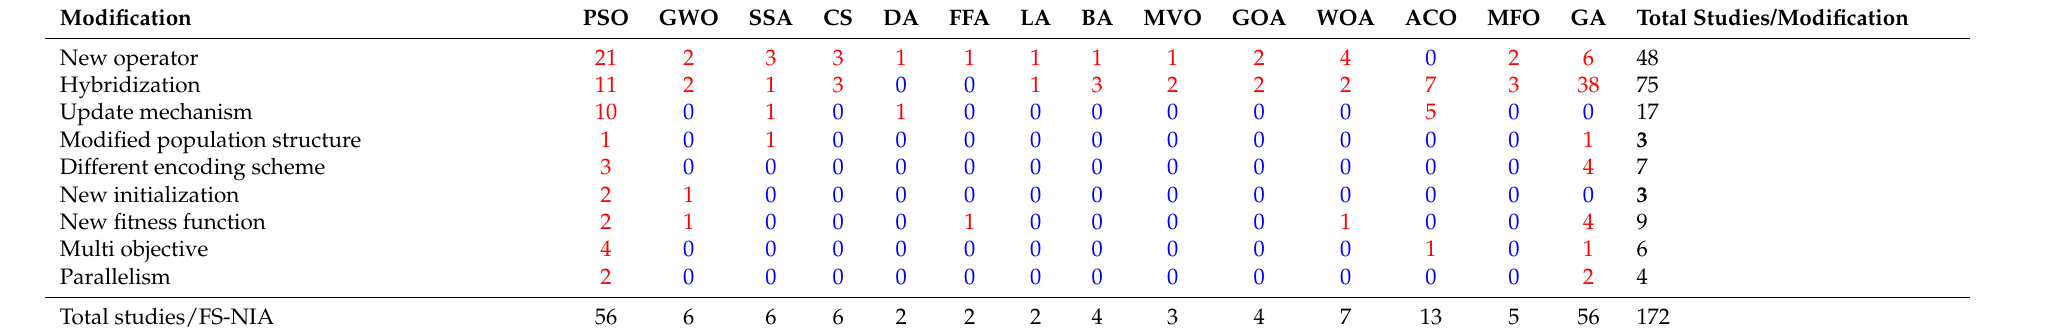
Table 5. Summary of main modifications applied in the literature on main NIAs-FS (by number of